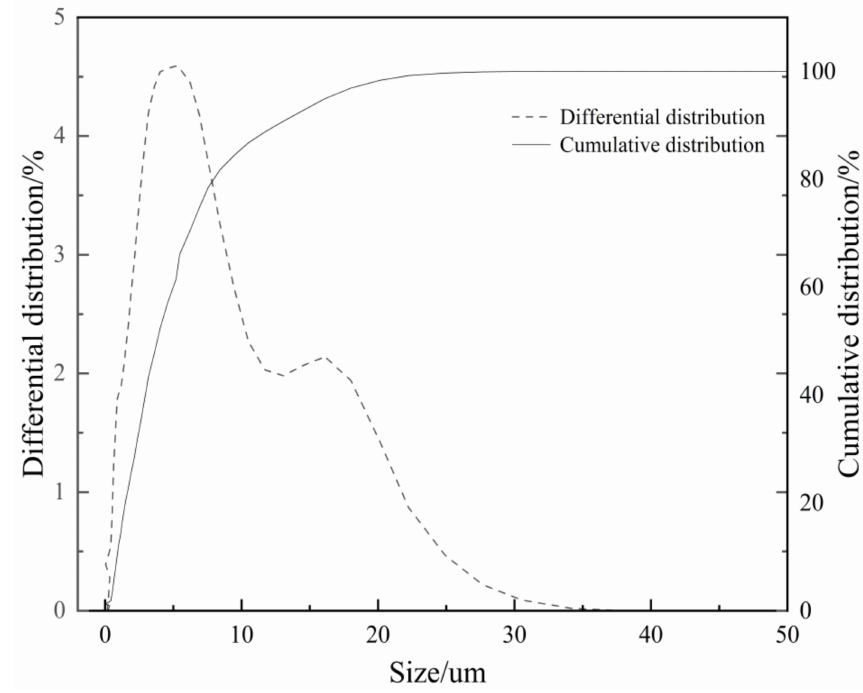
Figure 6. Grain size of muscovite.